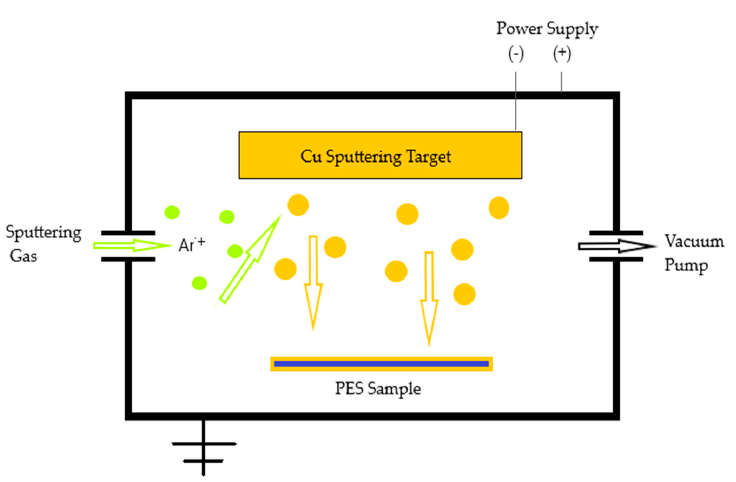
Figure 2. The schematic diagram of applied DC magnetron sputtering system.